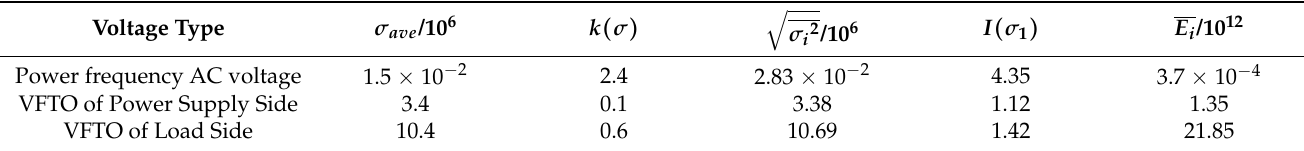
Table 2. Characteristic parameters of power frequency AC voltage and